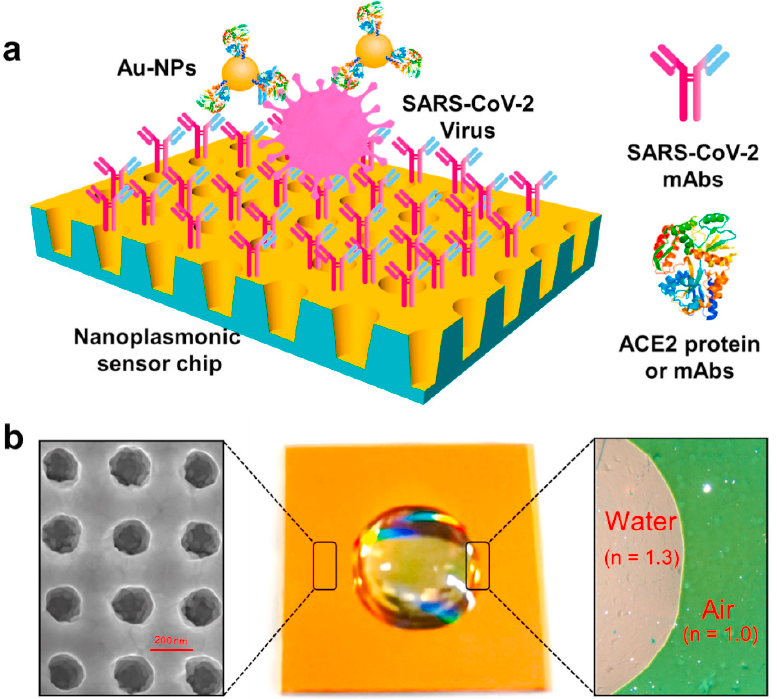
Figure 5. Label-free detection of SARS-CoV-2 pseudovirus with a nanoplasmonic sensor. ( a ) Schematic diagram of the nanoplasmonic resonance sensor for determination of SARS-CoV-2 pseudovirus concentration. ( b ) Photograph (Middle) of one piece of Au nanocup array chip with a drop of water on top. Scanning electron microscopy image (Left) shows the replicated nanocup array. Transmission microscopy image (Right) shows that air and water on the device surface exhibit different colors, green and far-red pink, respectively. Reprinted permission obtained from [73] .